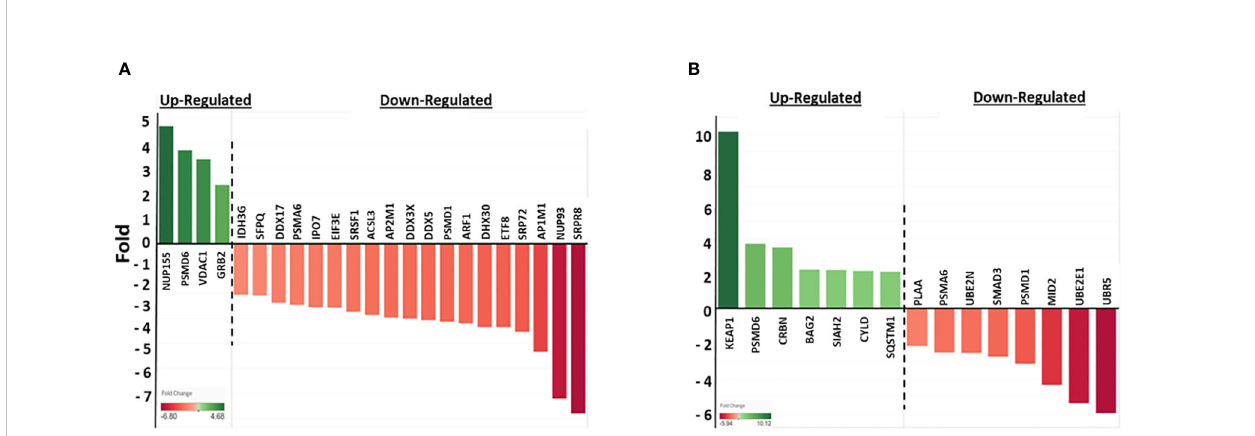
FIGURE 3 Nef-mediated changes in ubiquitination of cellular proteins that directly interact with Nef or the UPS. (A) Nef-mediated ubiquitination fold change in proteins that directly interact with Nef. Twenty-three of the 325 cellular proteins identi fi ed in Figure 2A directly interact with Nef, according to the data collected from the NIH GENE database (https://www.ncbi.nim.nih.gov/gene). The fold changes in ubiquitination in the presence of Nef range from 6.8- fold decrease to a 4.68-fold increase, with greater color intensity corresponding to larger fold changes. The fold changes associated with cellular proteins for which Nef up-regulated ubiquitination are depicted in green, while those with down-regulated ubiquitination are in red. (B) Nef-mediated ubiquitination fold changes in proteins that directly interact with the UPS. Fifteen of the 325 cellular proteins identi fi ed in Figure 2A directly interact with UPS, according to the data collected from the WikiPathways database (https://www.wikipathways.org/). The fold changes in ubiquitination range from a 5.94-fold decrease to a 10.12-fold increase. The same color coding was used in both panels (A, B)